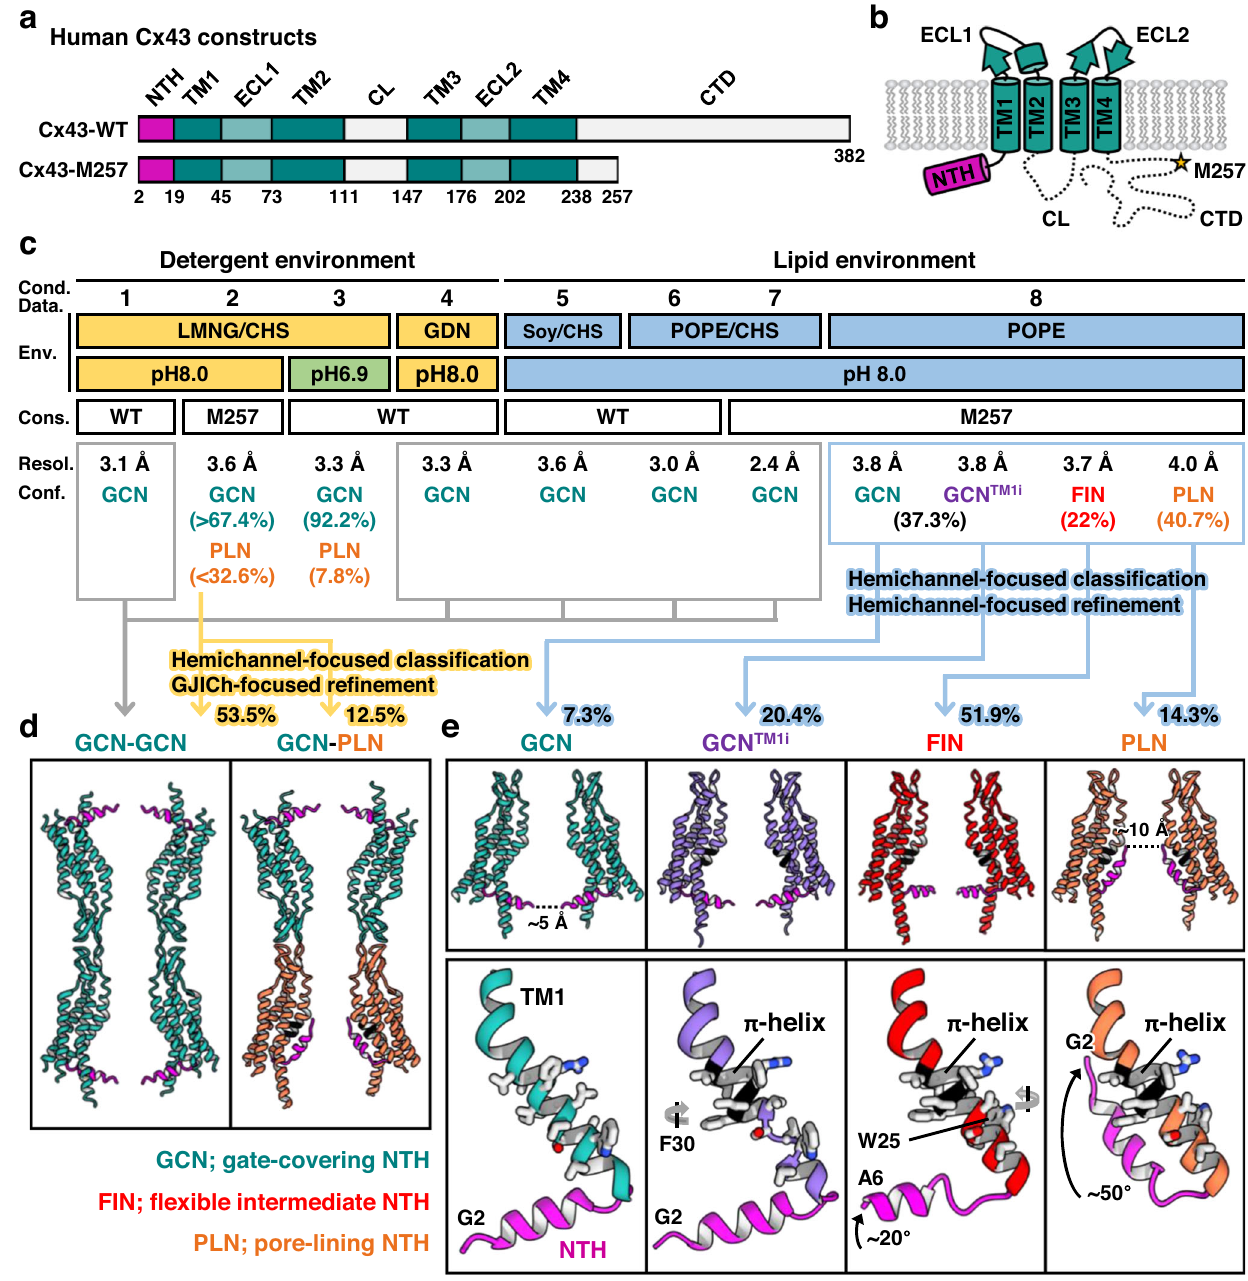
Fig. 1 | Overview of the puri fi cation and structural determination of Cx43 GJICh.a DomainarchitecturesofCx43-WTandCx43-M257. b Topologydiagramof Cx43. The dashed lines indicate fl exible loops that could not be structurally determined. The M257 residue is marked and labeled. c Puri fi cation conditions for Cx43-WT and Cx43-M257. The fi nal buffer conditions for Cx43 proteins are indi- cated, such as pH, detergents, and lipid composition. The percentages of the GCN and PLN protomers in parentheses are indicated as per the promoter-focused analyses.SeetheMethodssectionfordetails.Abbreviations:cond.,condition;data, dataset; env., environment; cons., construct; resol., resolution; conf., conforma- tion. d Ribbon presentation of the conformationally homotypic (left; conditions